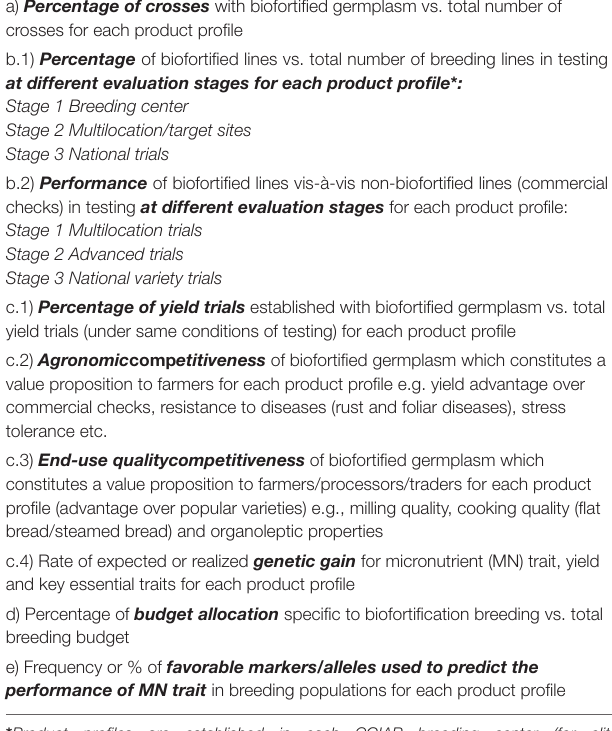
TABLE 3 | Indicators for assessing and monitoring the transition to mainstreaming of biofortification in self-pollinating crops. a) Percentage of crosses with biofortified germplasm vs. total number of crosses for each product